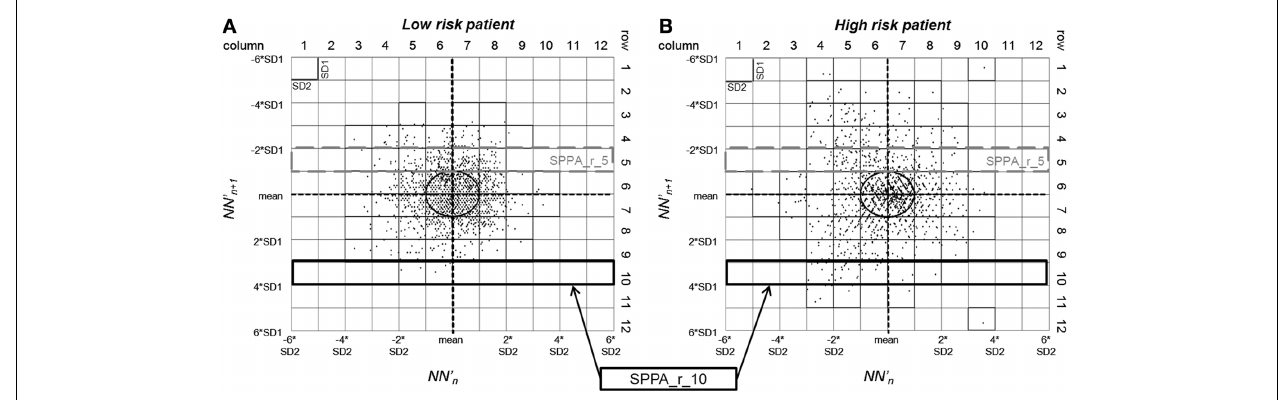
FIGURE 5 | SPPA plot with marked indices SPPA_r_5 and SPPA_r_10 of two patients (A): low risk, (B): high risk.